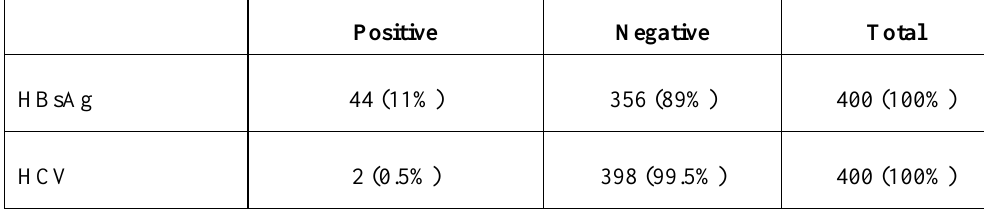
Table 2. Prevalence of HBsAg and HCV among pregnant women in